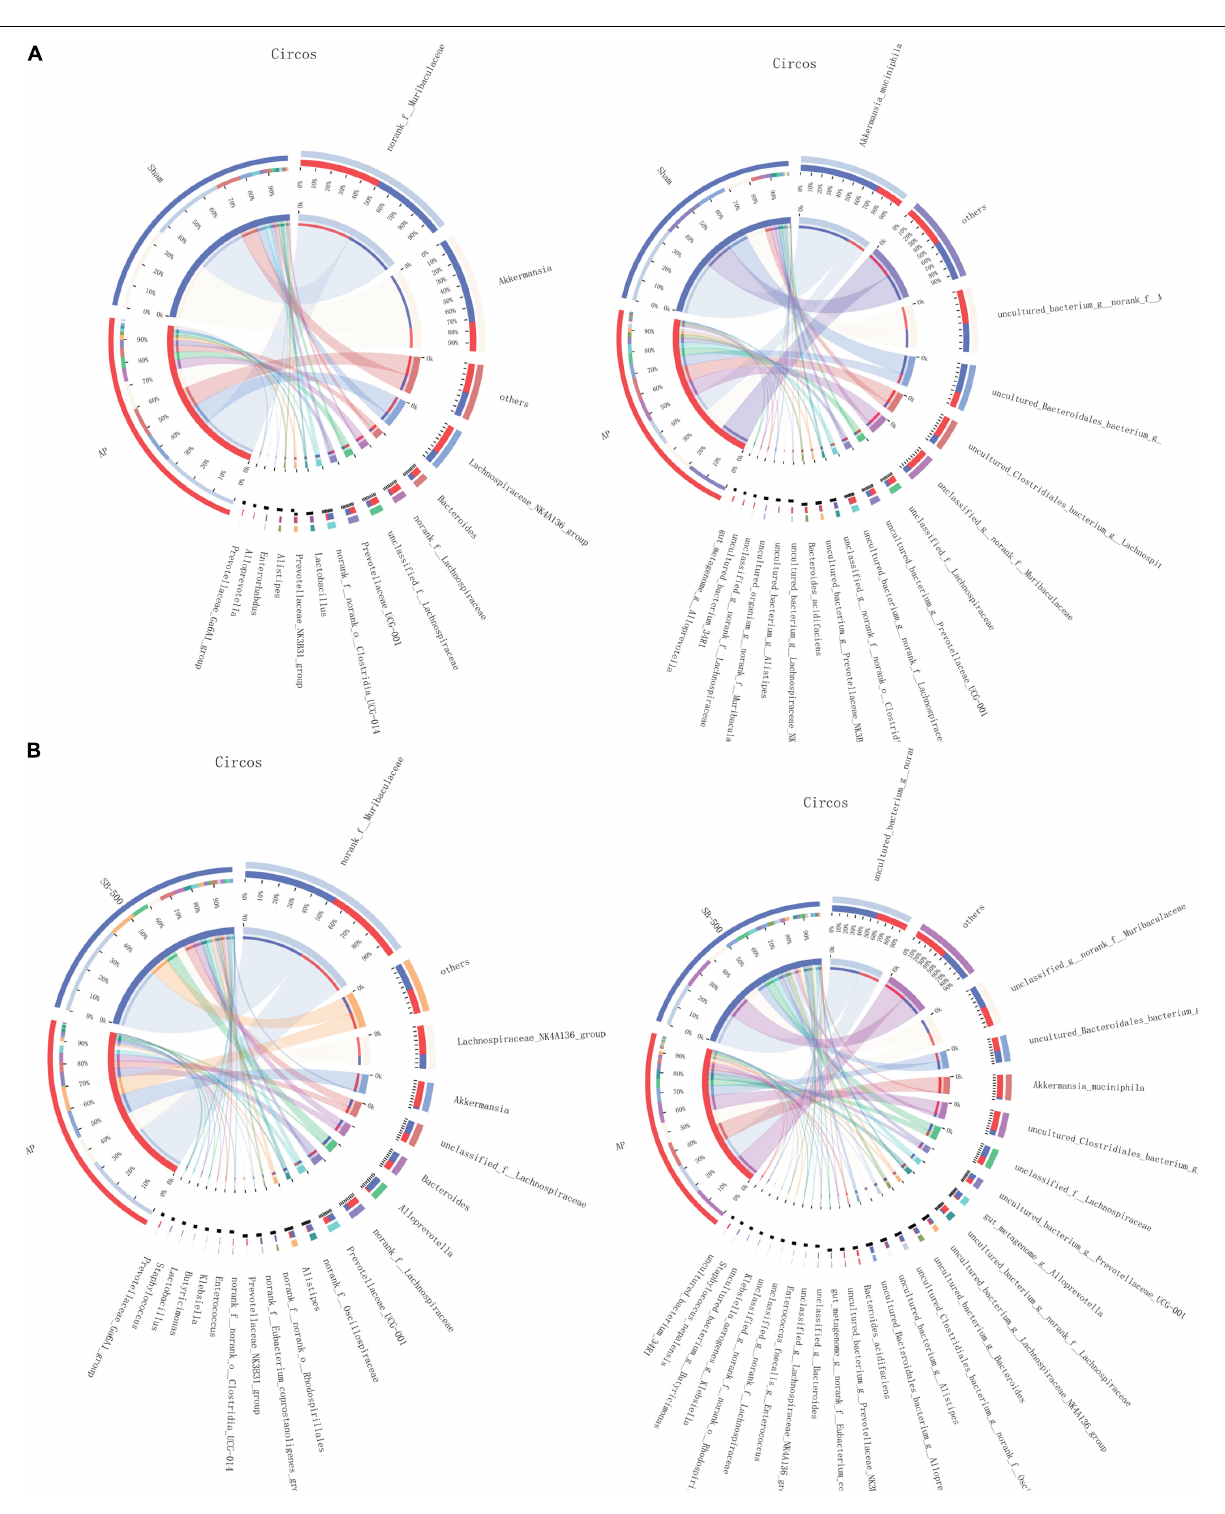
Frontiers in Physiology |